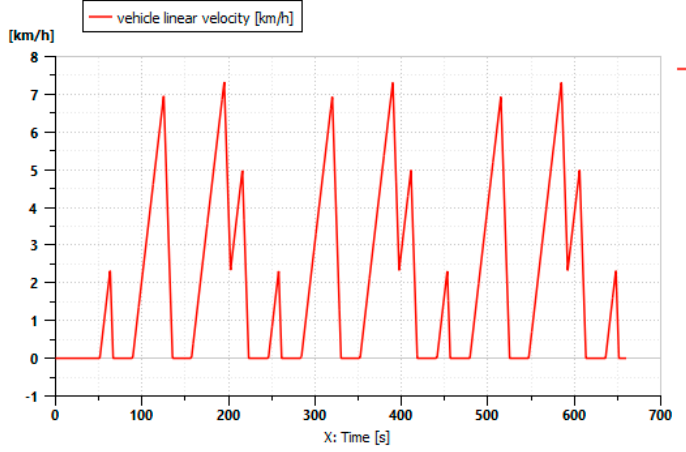
Figure 11. Tractor driving cycle with a moldboard plow attached.